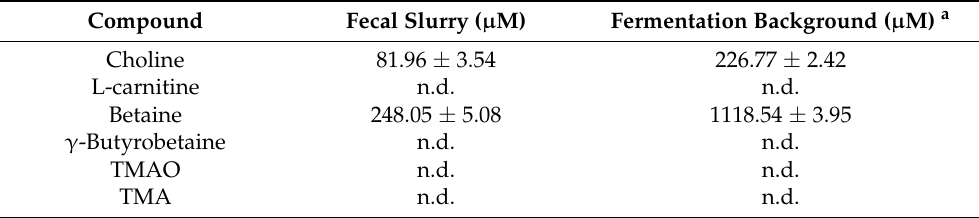
Table 1. Concentration of TMA and TMA-related compounds in fecal slurry and fermentation background (fermentation media + fecal slurry 1:10 (20%)). Compound Fecal Slurry ( µ